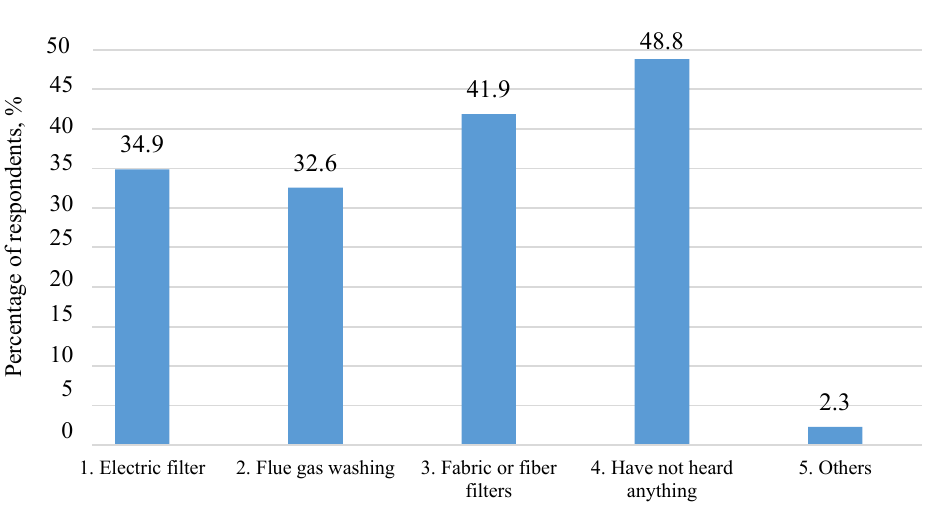
Fig. 4. Respondents knowledge on flue gas treatment